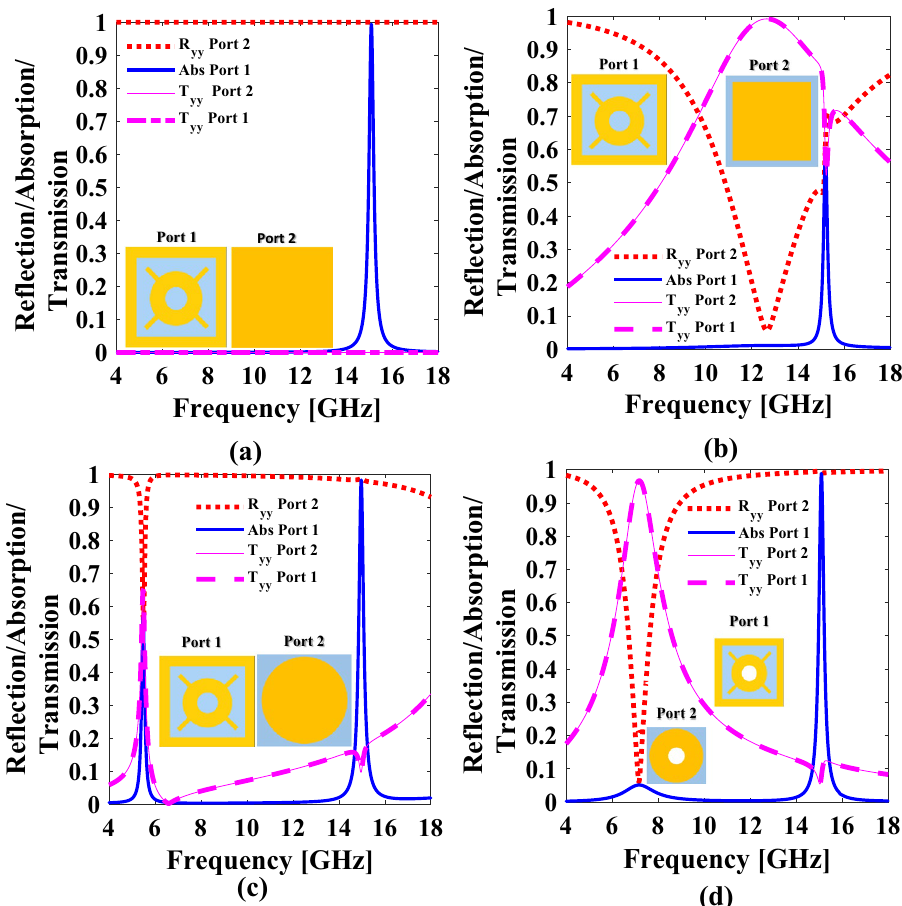
Figure 2. Unit cell design evolution ( a ) Square patch enclosing a circle with four rectangular stubs with a complete ground ( b ) Replacing a complete ground with a square patch ( c ) Replacing a complete ground with a circular patch ( d ) Creating a hole through the dielectric to enhance out of band transmission. *The figure is created using MATLAB ver. R2020A-URL: https:// www. mathw orks. com/ produ cts/ matlab.